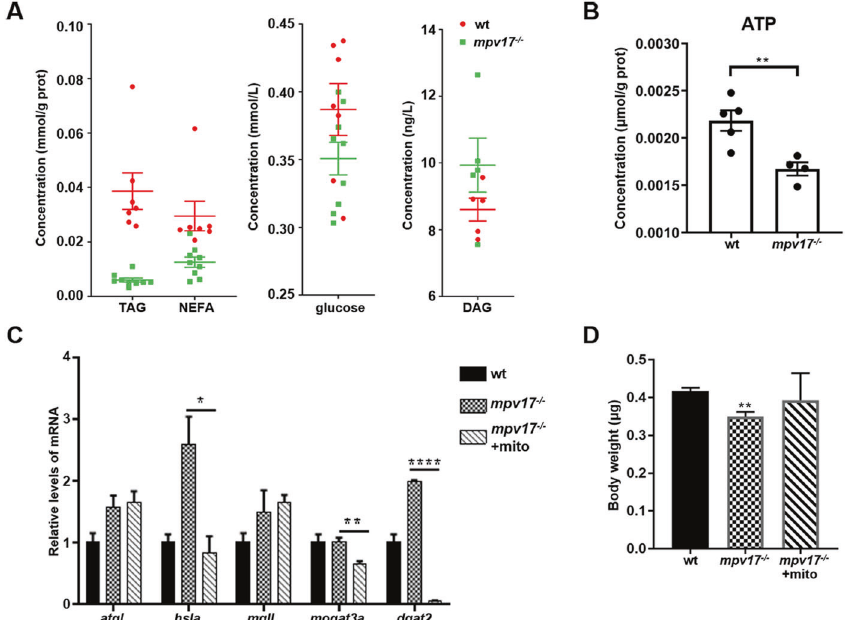
Fig. 4 The mpv17 − / − zebra fi sh with low contents of TAG and normal mitochondria could rescue the expression of the genes in the TAG metabolism. A The contents of the DAG, TAG, NEFA, and glucose were measured at 7 dpf stage. B The content of ATP was evaluated at 7 dpf. C The relative mRNA expression levels of genes involved in the TAG metabolism in mpv17 − / − larvae with or without normal mitochondria injection. D The bodyweight of the mpv17 − / − larvae with or without mitochondria injection. Error bars were indicated with ±SEM, * p < 0.05, ** p < 0.01, **** p <